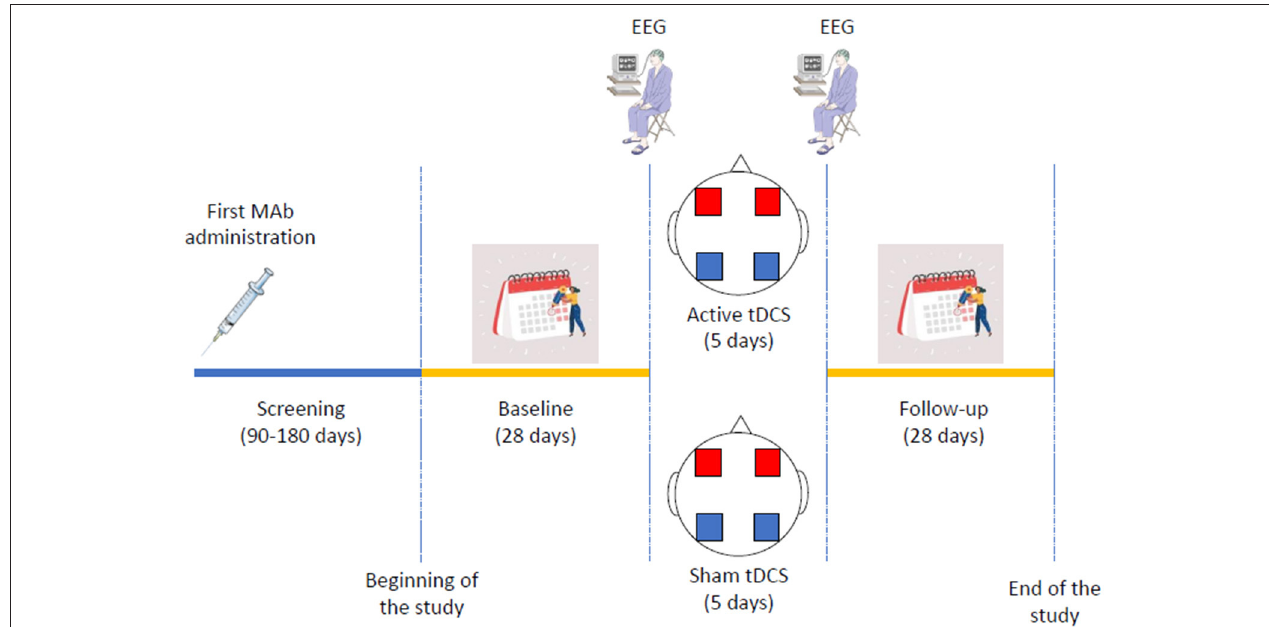
FIGURE 1 | Schematic representation of trial procedures. Mab indicates monoclonal antibody; EEG, electroencephalogram; tDCS, transcranial direct current stimulation. In the transcranial direct current stimulation figure, blue squares indicate the cathodes, while red squares indicate the